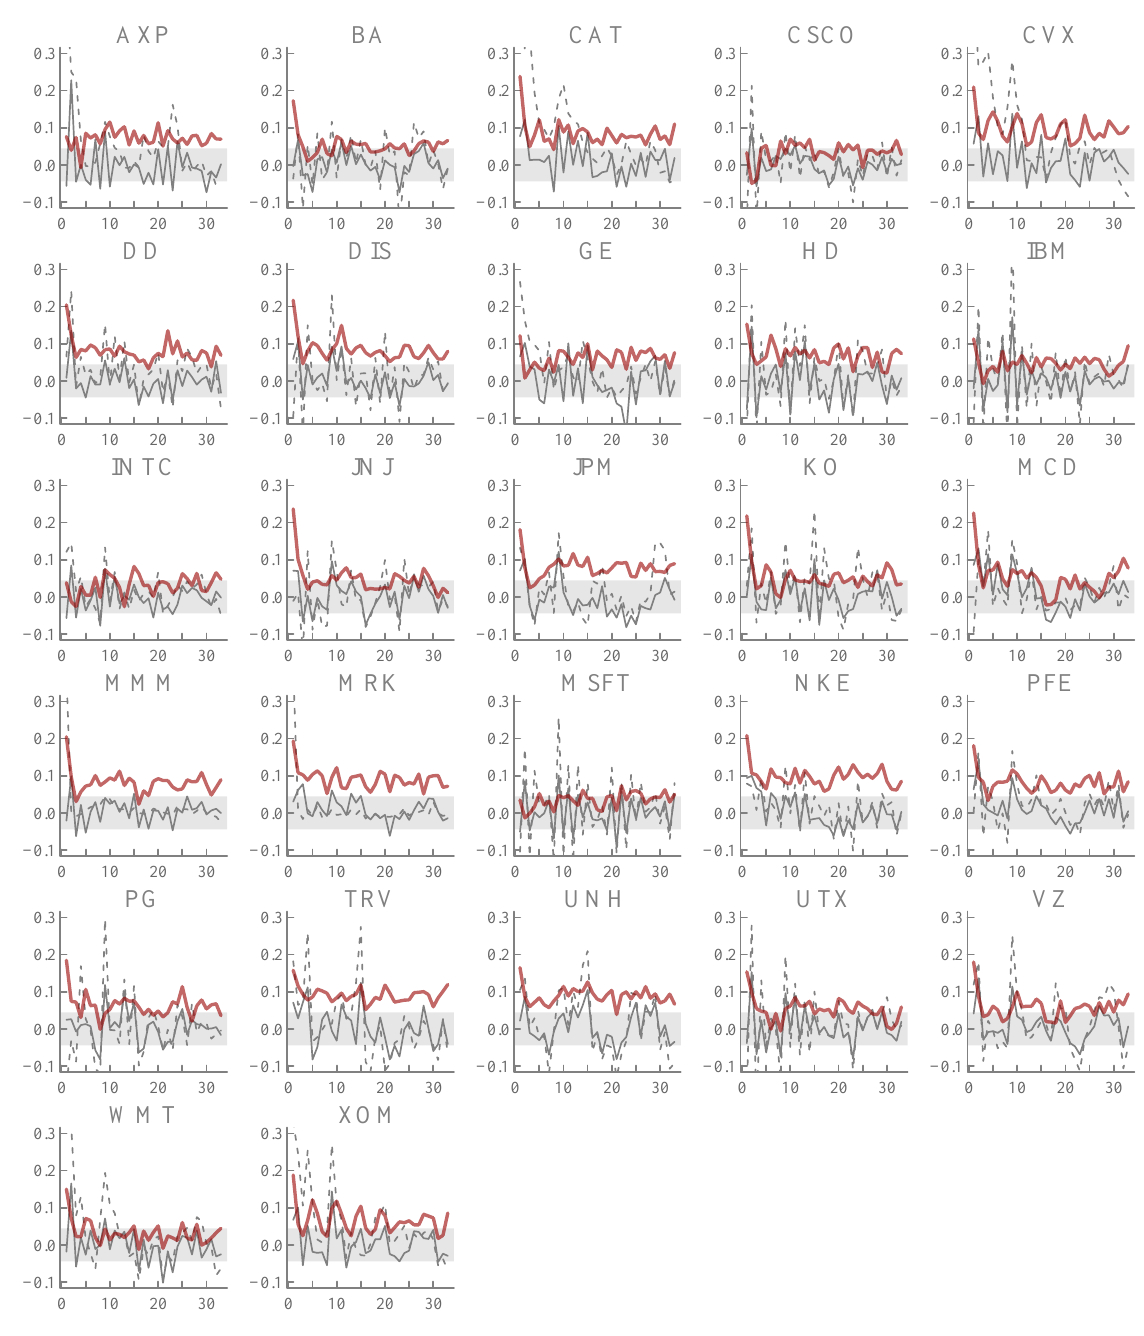
( h ) − (cid:98) y ( h ) Figure A2. Autocorrelations of forecast errors e t = y for stepsize h = 1 day. The autocorre- √ t t RV (gray), for HARQ with y = RV (dashed gray), and for RQ -in-mean lations for HAR with y = with y = ln ( RV ) (red line) should all be white noise if e t is iid . The gray shaded area is the two standard error band for a white noise series. The rolling forecasts are generated with a rolling estimation window of 8.67 years (104 months) followed by a one month prediction window shifted each month over 96 windows. The forecast sample is from 3 January 2006 to 31 December 2013 (2013 trading